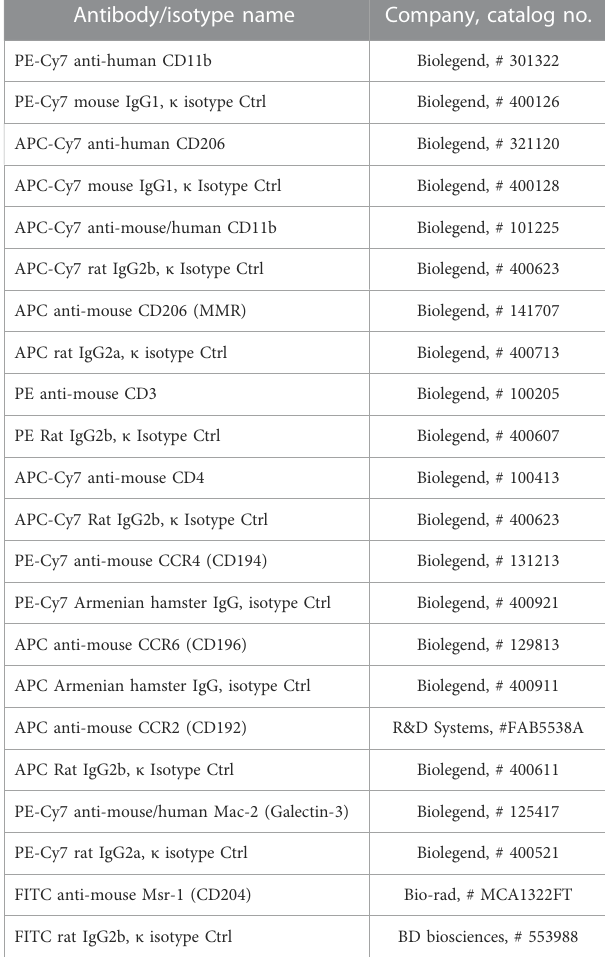
TABLE 2 Antibodies and isotype controls for fl ow